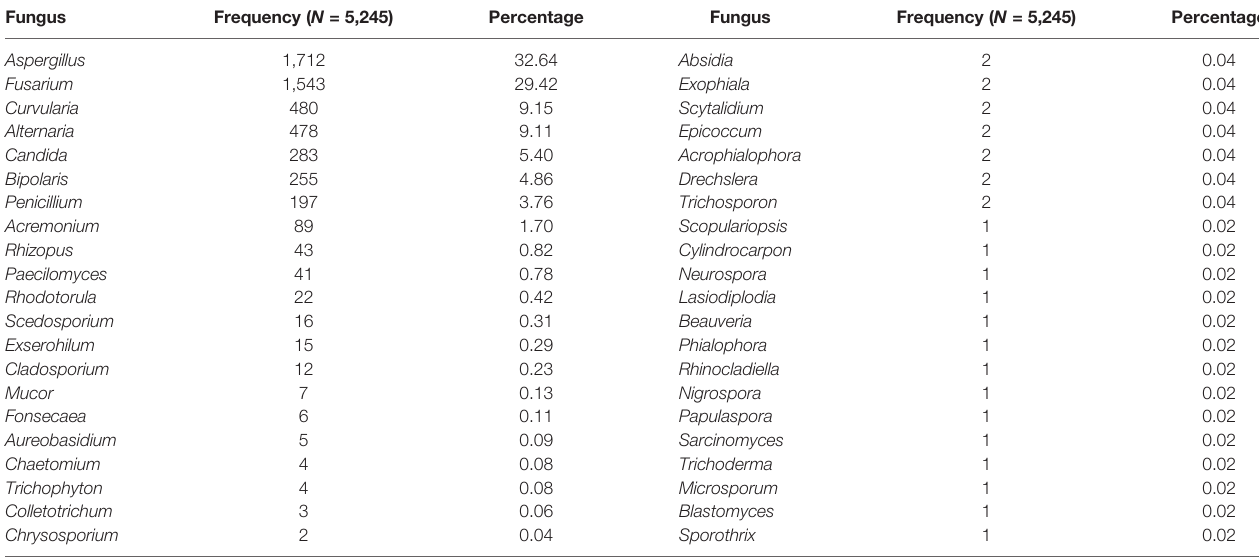
TABLE 5 | The spectrum and frequency of various fungi isolated from patients with clinically suspected fungal keratitis and identi fi ed at the genus level during 1990 to 2020 (5,245 out of 5,557 isolates have been identi fi ed). Fungus